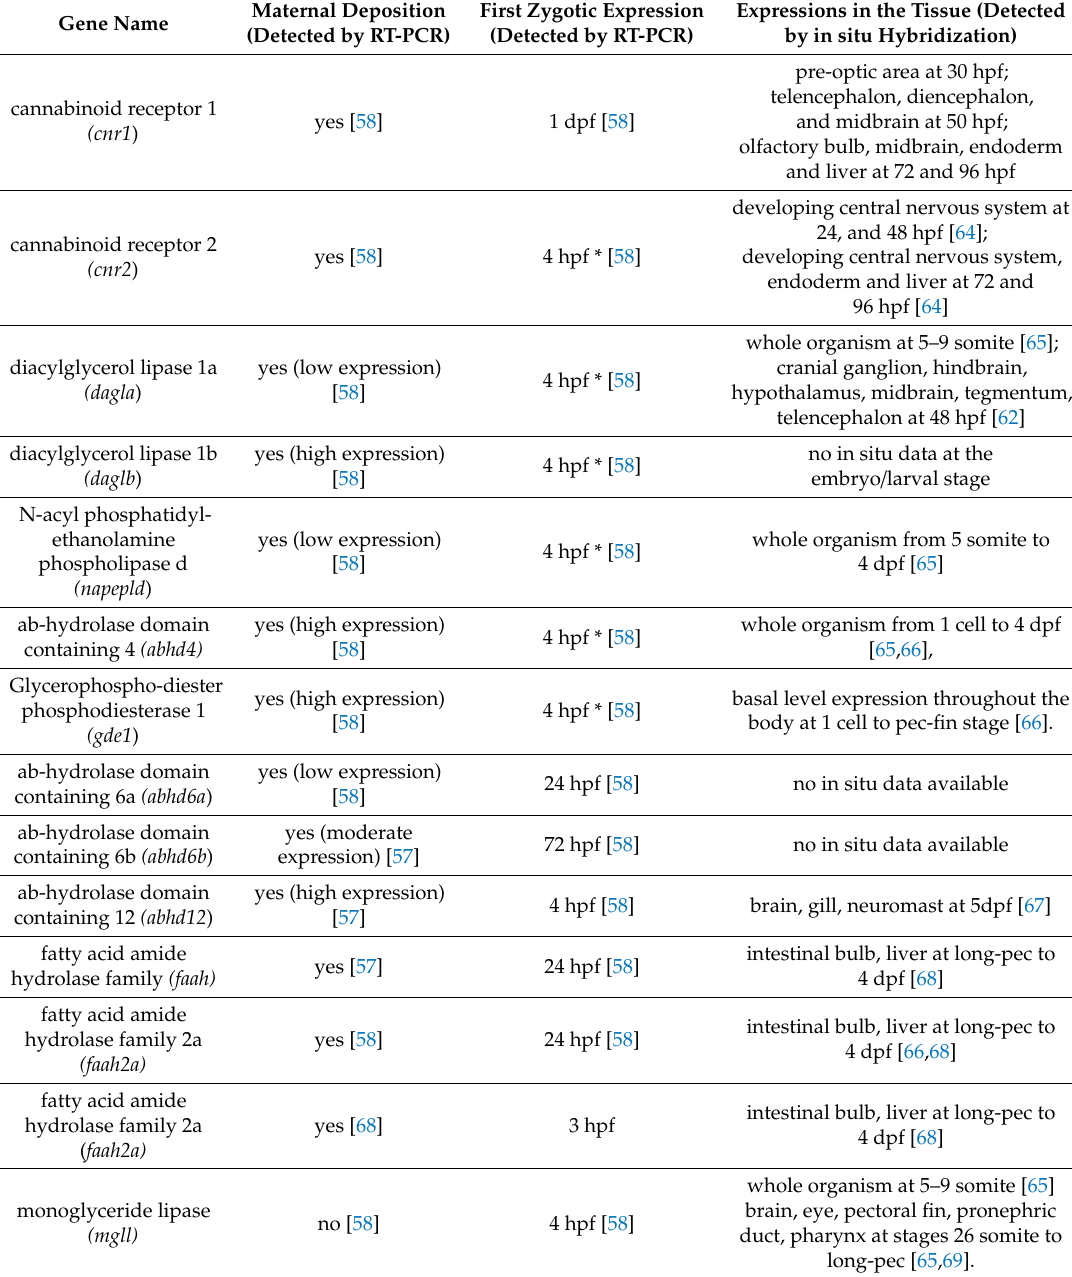
Table 1. Expression patterns of the zebrafish endocannabinoid signaling